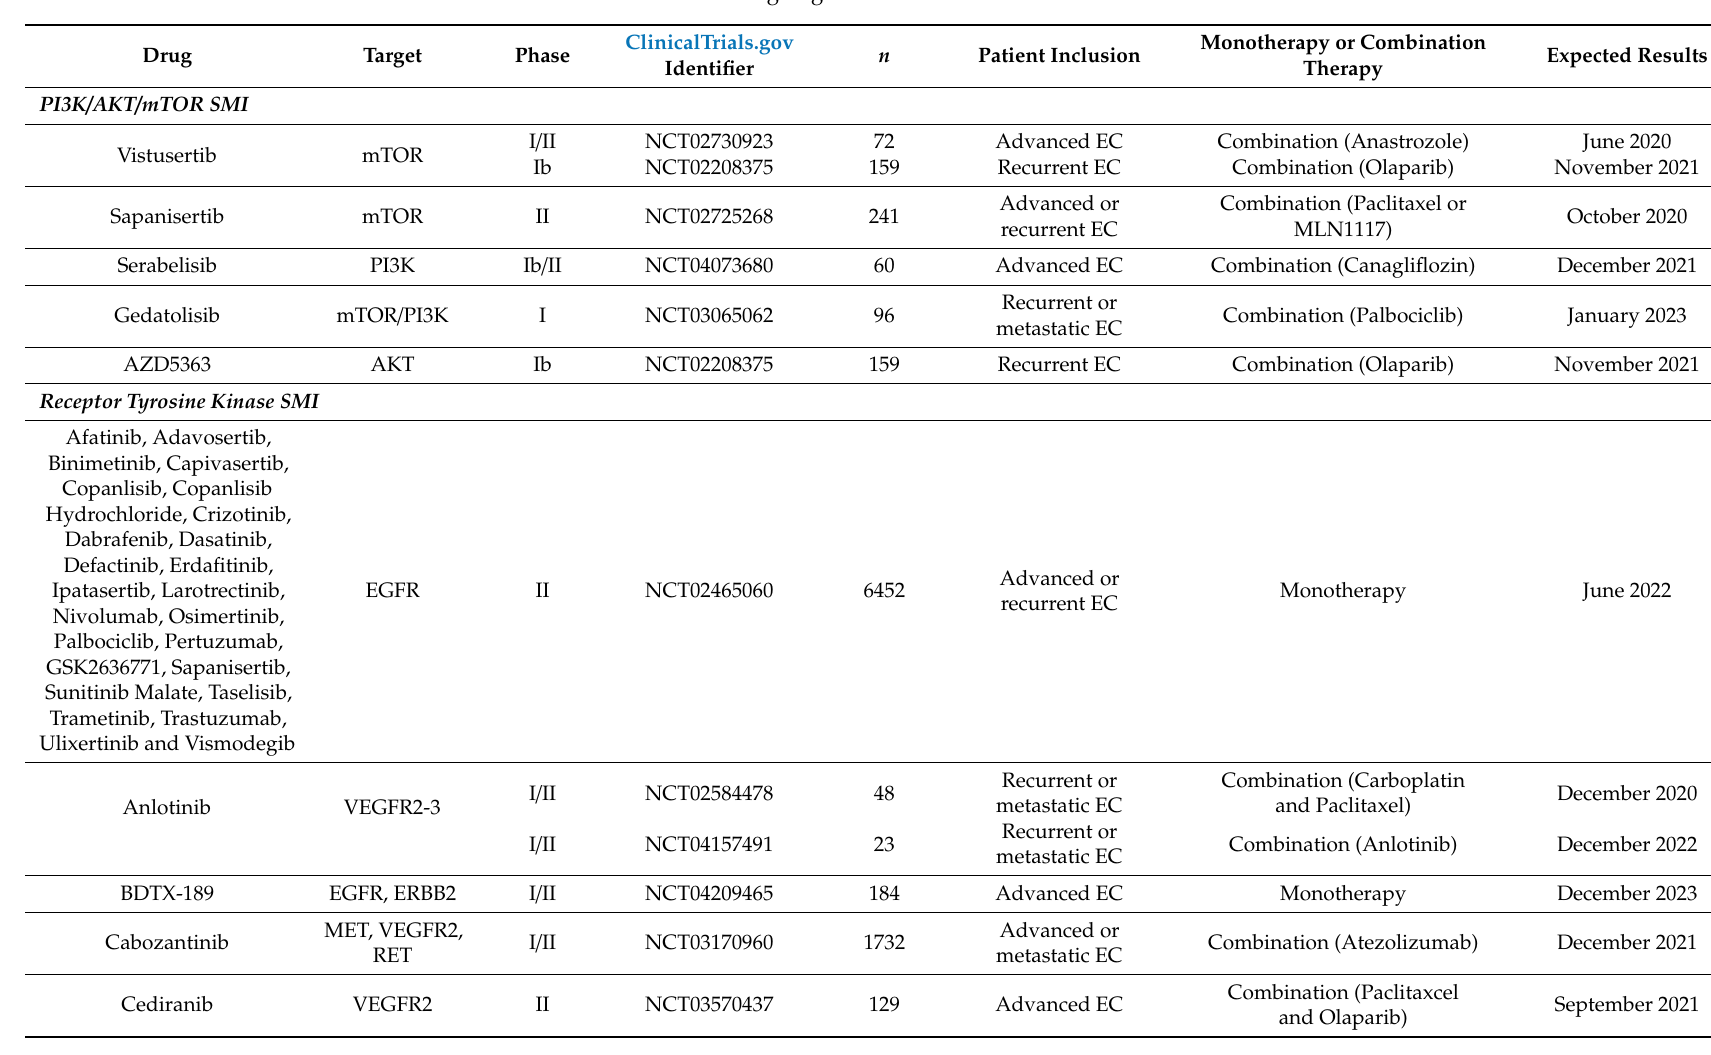
Table 3. Ongoing clinical trials of SMIs in